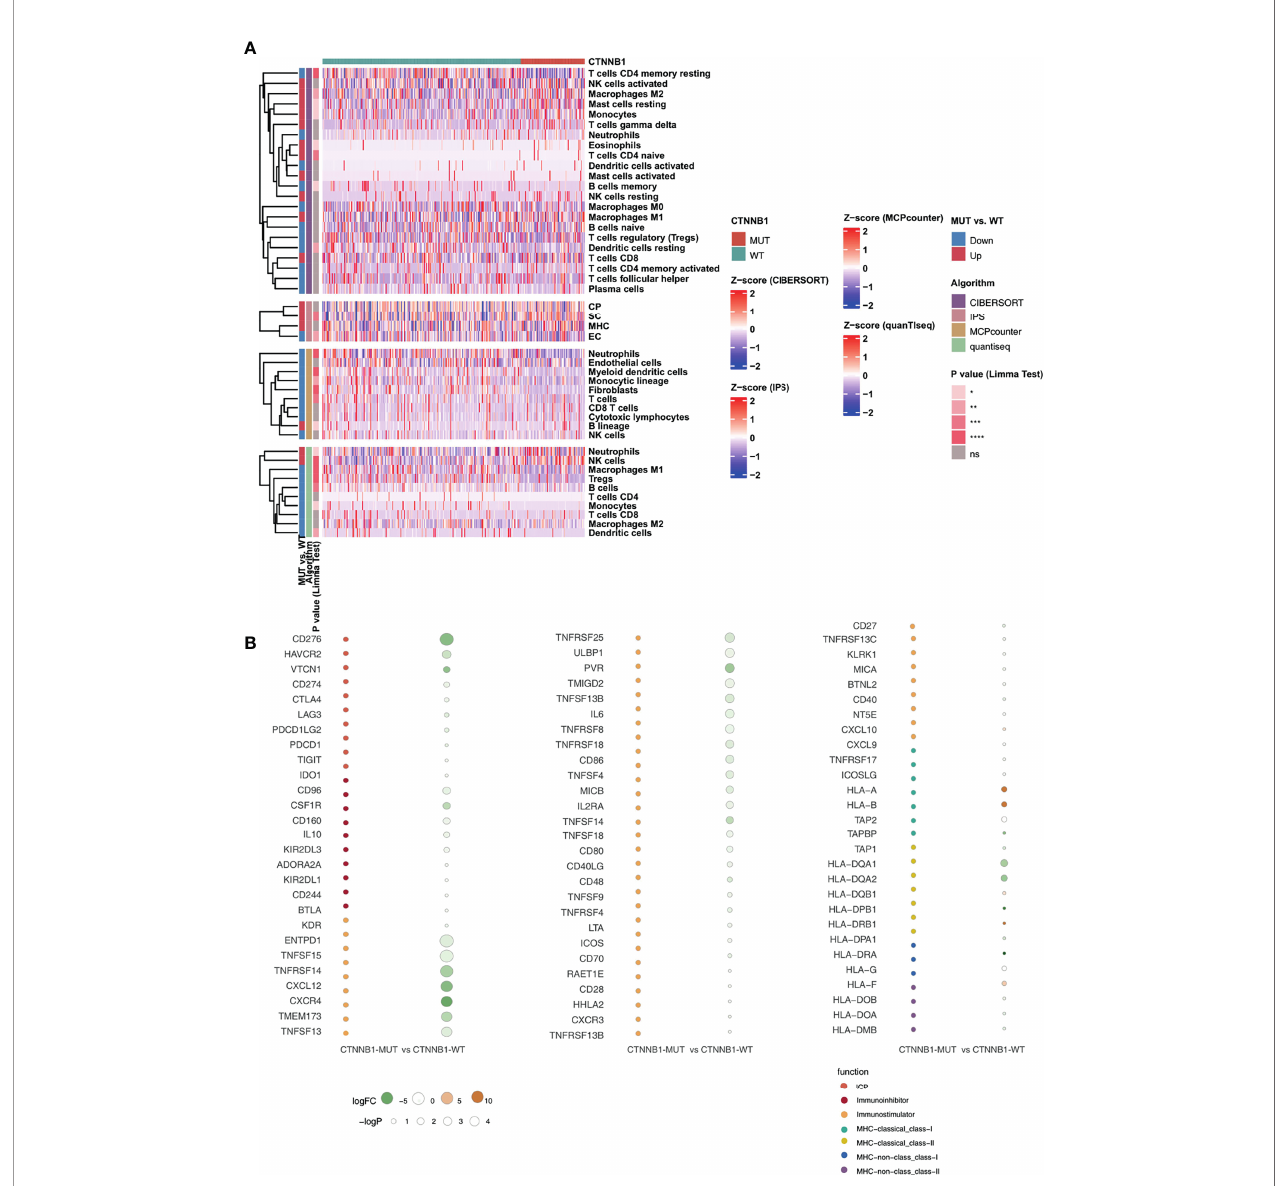
FIGURE 5 | CTNNB1-WT was associated with activated antitumor immunity. (A) Landscape of the immune cells for the TCGA-LIHC cohort. Immune cell scores estimated by the CIBERSORT, IPS, MCPcounter, and quanTIseq were analyzed using the Limma. Tobacco smoking history and clinical stage were analyzed using Fisher ’ s exact test. The corresponding levels of signi fi cance, algorithms and trend are displayed as a heatmap in the left panel. (B) Bubble plot depicting the mean differences in immune-related gene mRNA expression between CTNNB1-MUT and CTNNB1-WT tumors in the TCGA-LIHC cohort. The x-axis indicates different histological subtypes and the y-axis indicates gene names. The size of the circle represents the difference [-log10(p-value)] of each indicated immune signature or immune-related gene between CTNNB1-MUT and CTNNB1-WT tumors. Orange indicates upregulation, while green indicates downregulation. *P < 0.05; **P < 0.01; ***P < 0.001; ****P < 0.0001; ns, not signi fi